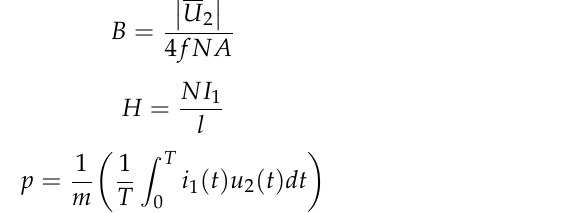
Figure 3. Specific losses curve of lamination materials: FeSi, VaCoFe obtained experimentally and from manufacturer’s datasheet, at 50 Hz and 400 Hz.